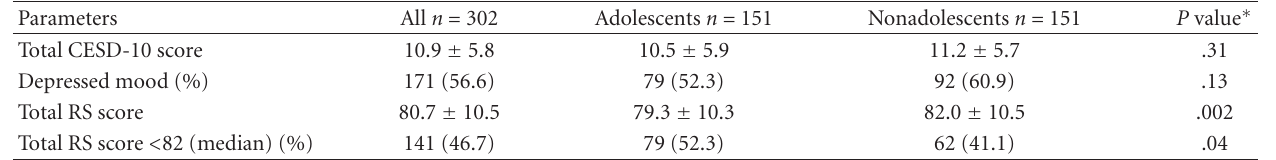
Table 3: Total CESD-10 and RS scores among studied